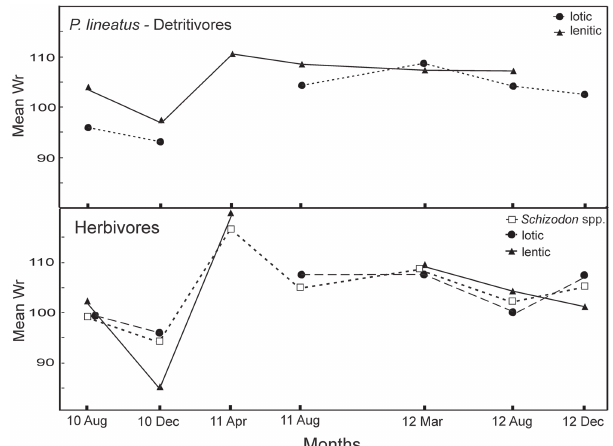
Fig. 6. Spatial and temporal variation in body condition average in Prochilodus lineatus per habitat; Schizodon spp. ( S. platae and S. borellii ) total and per